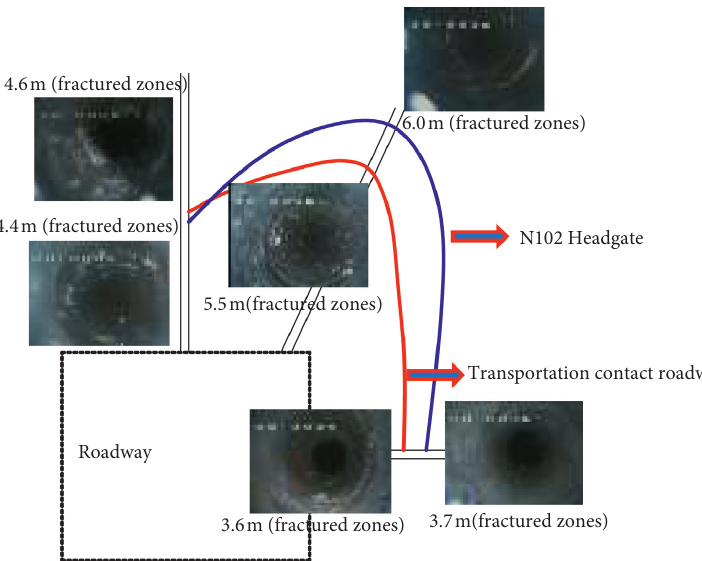
Figure 12: Drilling and peeping of the surrounding rock of the